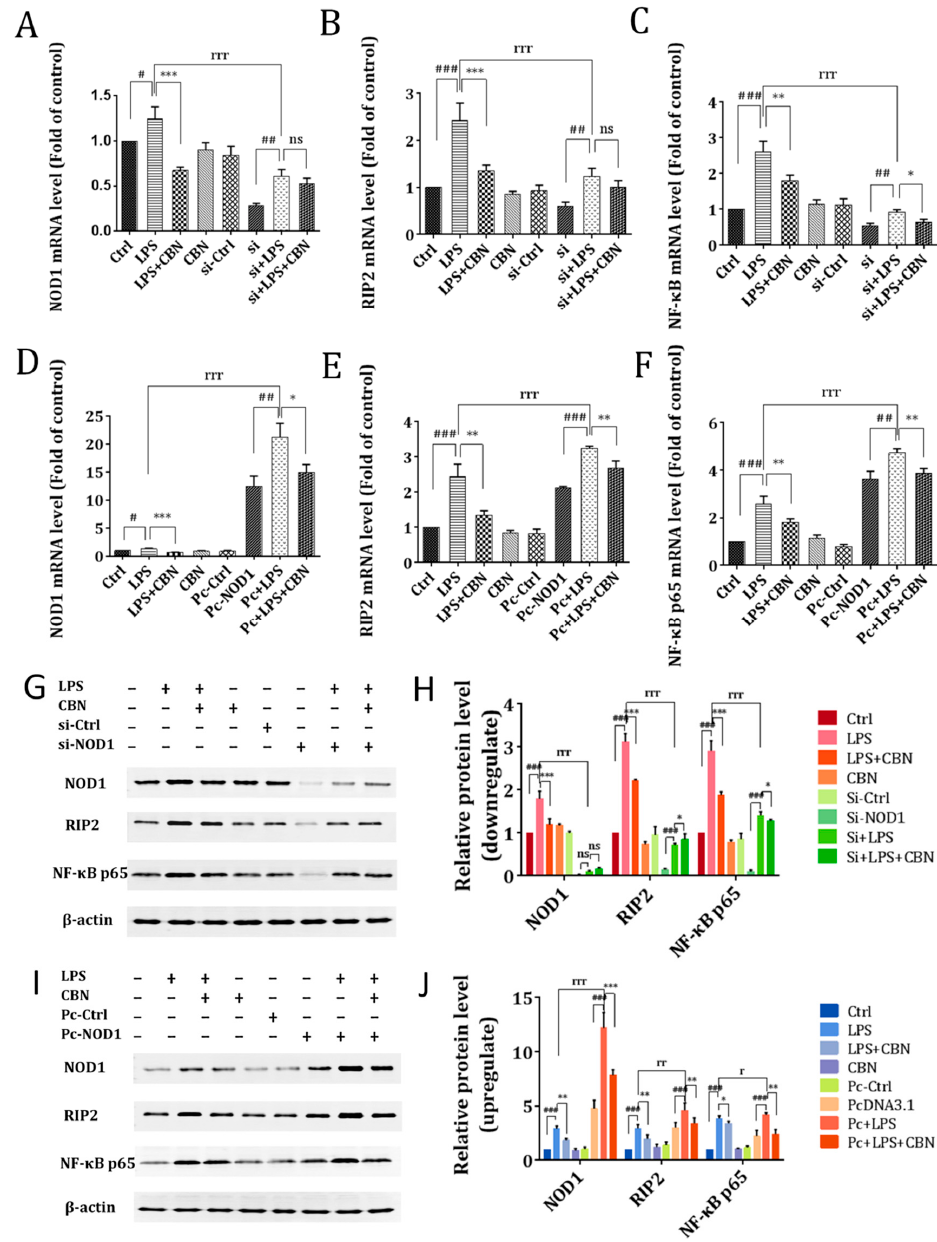
Figure 3. CBN inhibited the gene and protein expressions of the NOD1/RIP2/NF- κ B pathways by blocking NOD1 activation. ( A – F ) indicate the gene expressions of the NOD1 pathway. ( A ) NOD1 , ( B ) RIP2 , and ( C ) NF- κ B p65 gene expressions after NOD1 siRNA transfection in THP-1 cells. ( D ) NOD1 , ( E ) RIP2 , and ( F ) NF- κ B p65 gene expressions after pcDNA -NOD1 transfection in THP-1 cells. ( G – J ) indicate the protein level and relative expression of the NOD1 pathway after NOD1 knockout ( G , H ) and forced expression of NOD1 ( I , J ). # P < 0.05, LPS group versus control group; ## P < 0.01, LPS group versus control group; ### P < 0.001, LPS group versus control group; * P < 0.05, drug group versus LPS group; ** P < 0.01, drug group versus LPS group; *** P < 0.001, drug group versus LPS group; r P < 0.05, (si + LPS/Pc + LPS)(si: NOD1 gene knockout; Pc: NOD1 gene overexpression) versus LPS group; rr P < 0.01, (si + LPS/Pc + LPS) versus LPS group; rrr P < 0.001 (si + LPS/Pc + LPS) versus LPS group; ns indicates no significance between the two groups. The results shown are representative of three independent experiments with similar results. Data are expressed as means ±